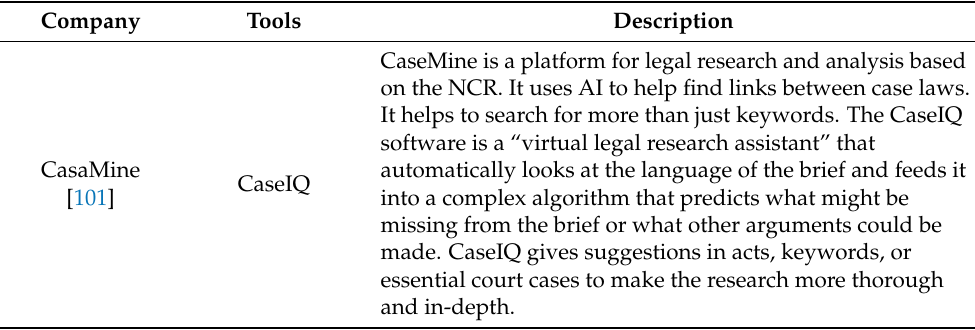
Table 1. AI-assisted technology platforms in Legal Industry & their